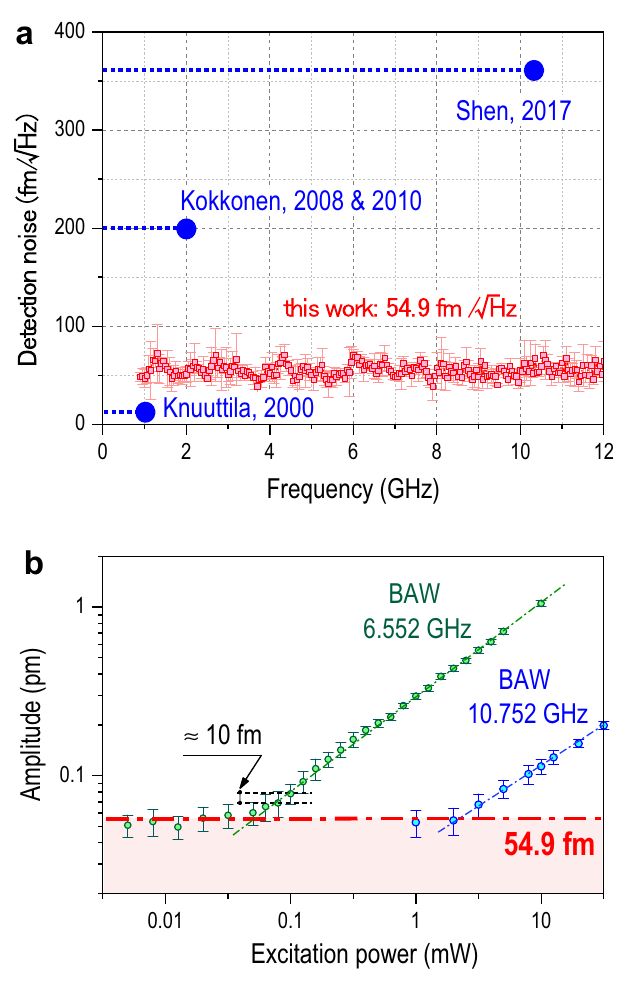
Fig. 4 Noise of stroboscopic optical sampling at super high frequencies. a Comparison between the noise fl oor of this work, obtained by disconnecting the power supply to the device under test (shown in red), and the noise fl oor for state-of-the-art CW laser interferometry 12,16,20 (shown in blue), for both measurement bandwidth and noise fl oor. b The root mean square (RMS) vibration amplitude of the third mode (6.552 GHz) and fi fth mode (10.752 GHz) of the BAW while the excitation power is gradually reduced, yielding a noise fl oor around 55 fm for a 1 s averaging time (red dash-dot line). In both panels ( a ) and ( b ), error bars represent ±1 σ . The relationship between the displacement and the square root of the RF power is linear as expected because the driven motion is governed by the inverse piezoelectric coupling, ε indicates that changes in vibration amplitude below 10 fm can be observed when the excitation power is